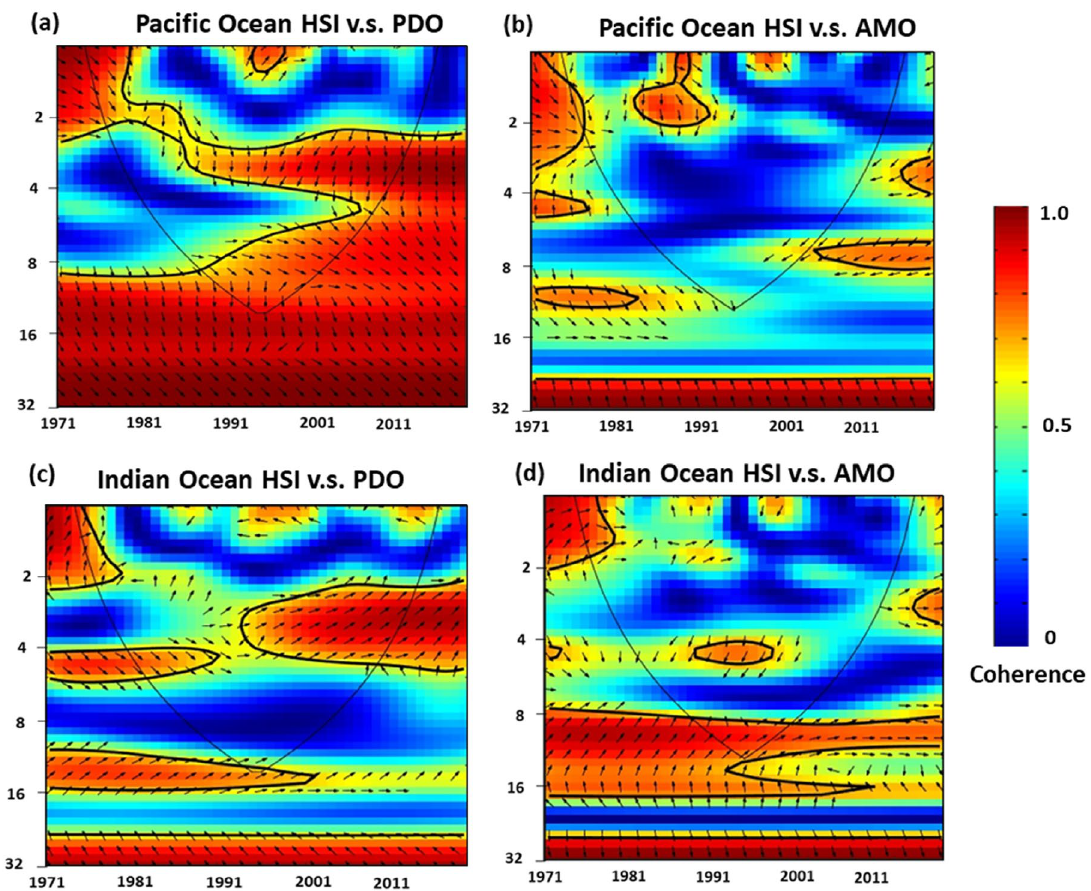
Figure 5. Cross-wavelet analyses of coherence between yellowfin tuna habitat suitability. ( a ) The HSI for yellowfin tuna in the Pacific Ocean compared with the PDO index. ( b ) The HSI for yellowfin tuna in the Pacific Ocean compared with AMO index. ( c ) The HSI for yellowfin tuna in the Indian Ocean compared with PDO index. ( d ) The HSI or yellowfin tuna in the Indian Ocean compare with AMO index. The solid black contours enclose regions of > 95% confidence, and the black lines indicate where the edge effects become salient. Red indicates high variability, and blue indicates low variability. Arrows indicate the phase relationships, with in-phase arrows pointing to the right and out-of-phase arrows pointing to the left.